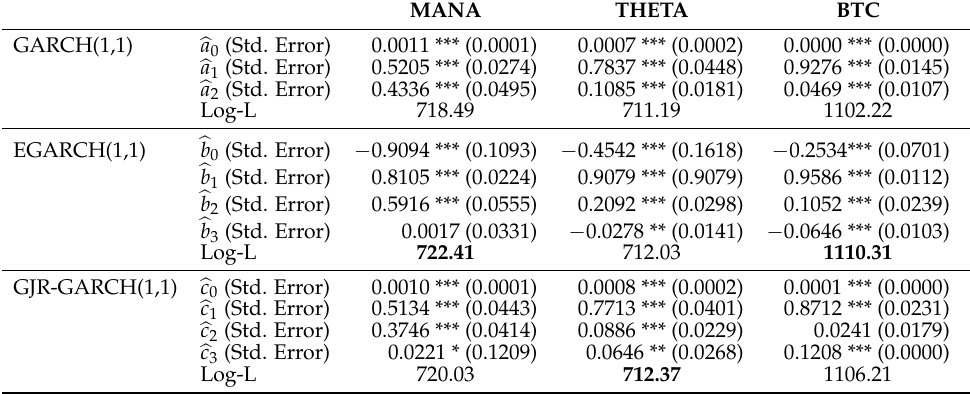
Table 5. Parameter estimation result for heteroskedastic